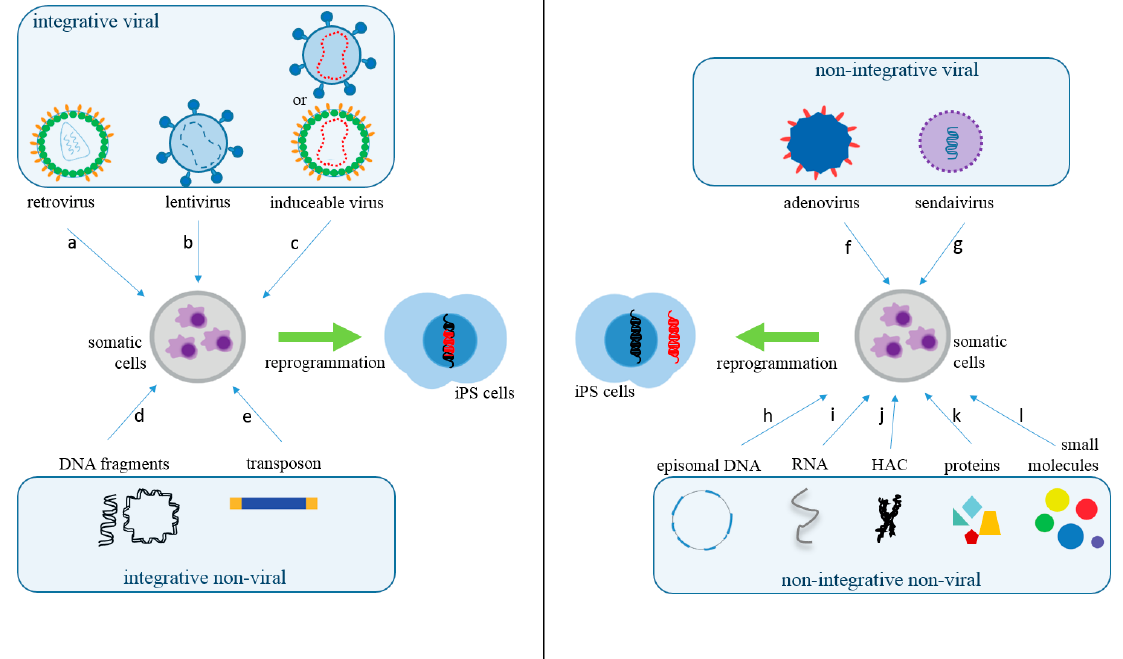
Figure 1. Somatic Cells Reprogramming Methods. The methods used to produce iPS cells can be classified into integrative viral, such as retrovirus (a), lentivirus (b), or inducible retro or lentivirus (c); and integrative non-viral, such as linear or circular DNA fragments (d) or transposons (e). In regards to non-integrative methods, they can also be separated as viral, such as adenovirus (f) or Sendai virus (g). Non-integrating non-viral methods are episomal DNA (h), RNAs (i), human artificial chromosome (HAC) (j), proteins (k), or small molecules (compounds) (l). The red DNA represents epigenetic inserted sequences for cellular reprogramming.